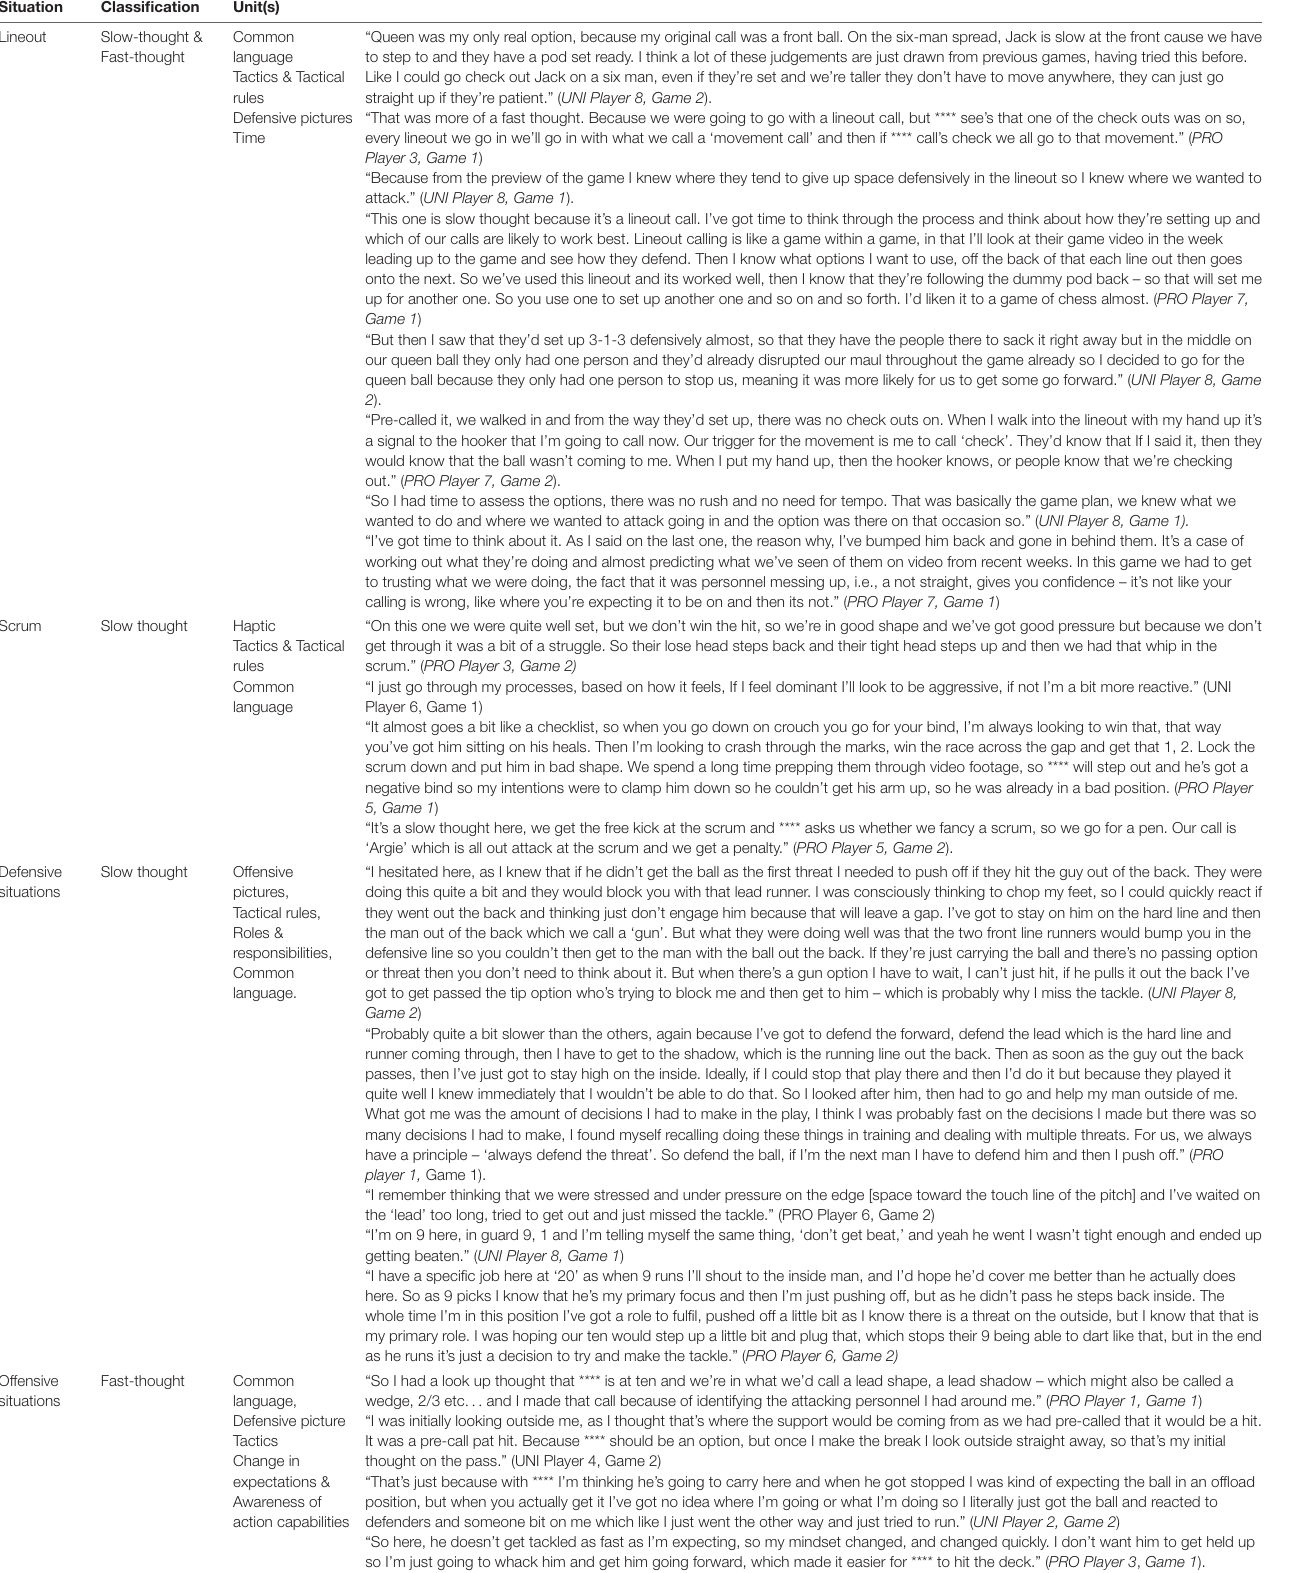
TABLE 4 | UNI and PRO Players verbalisations of decision making processes in response to specific game